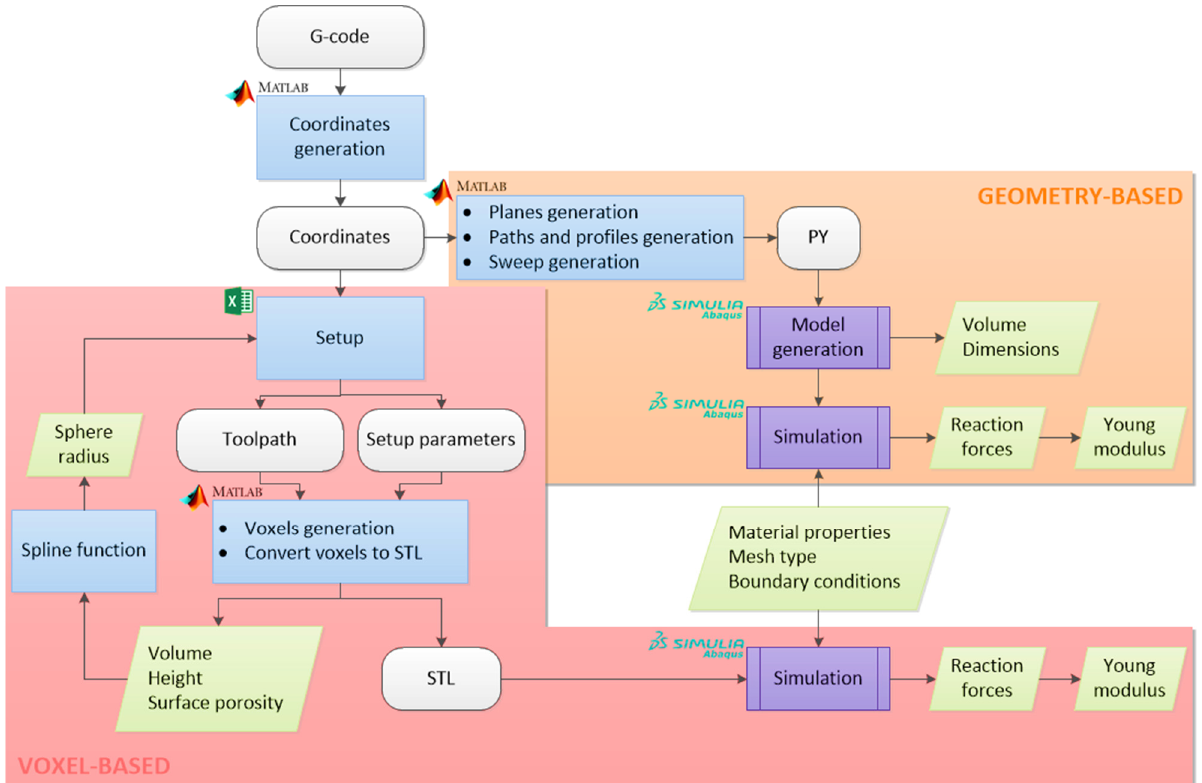
Figure 1. Flowchart of the modelling methodologies.